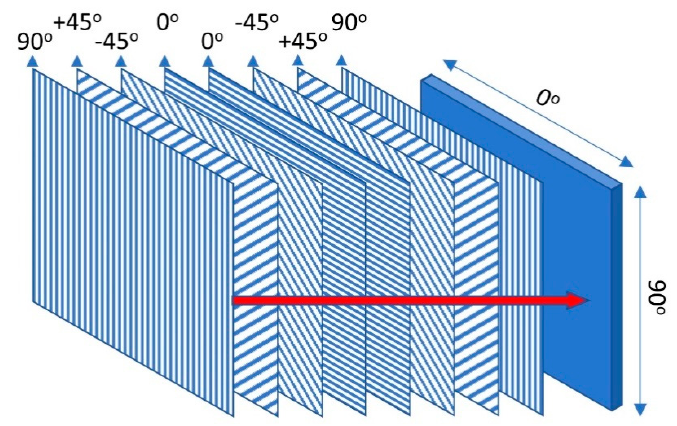
Figure 3. Stacking sequence of a laminate quasi-isotropic plate.